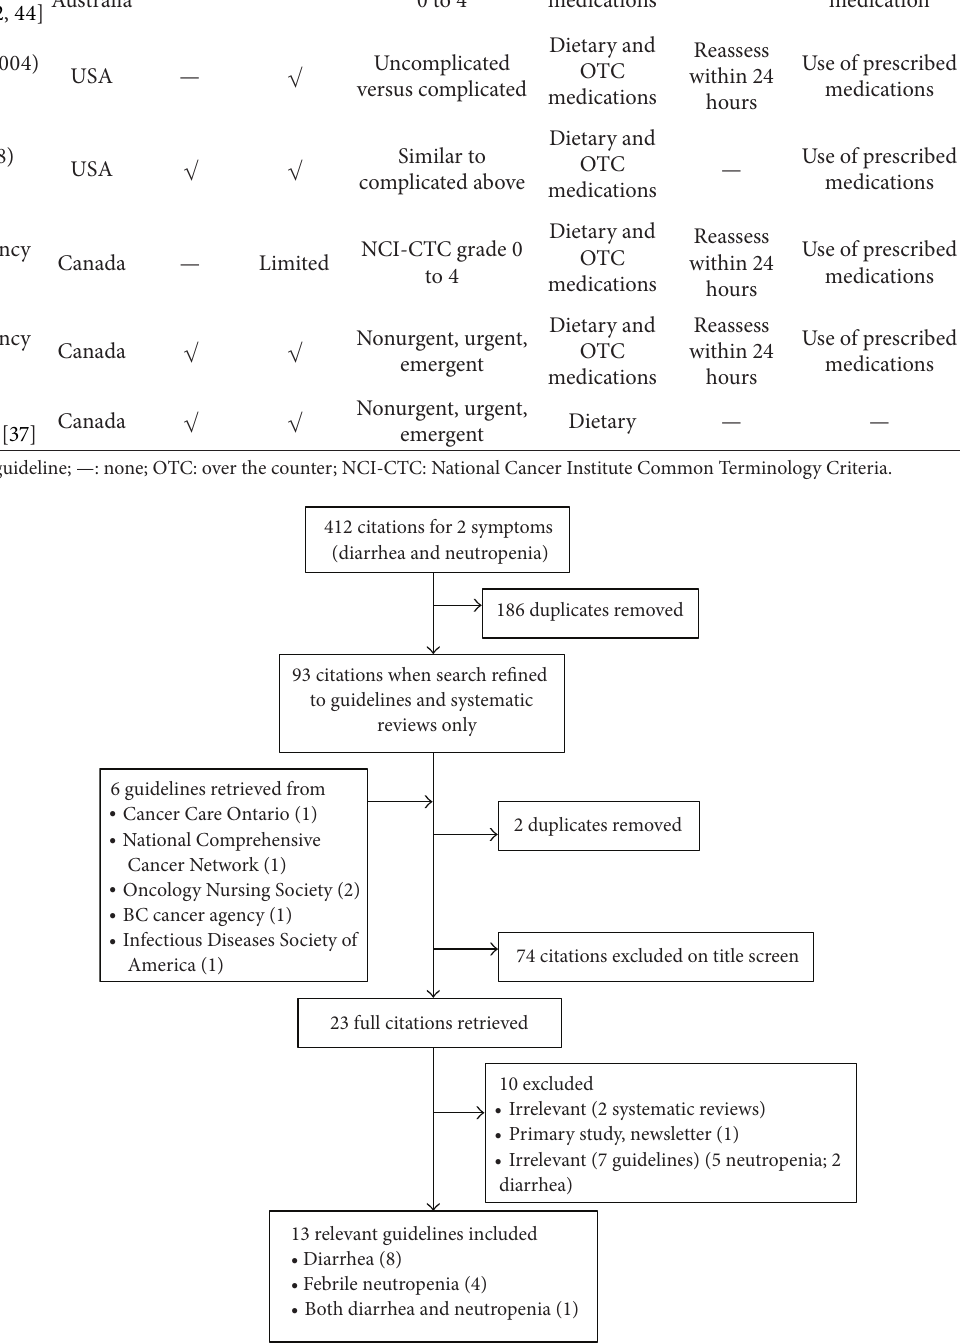
Figure 1: Flow of citations through screening